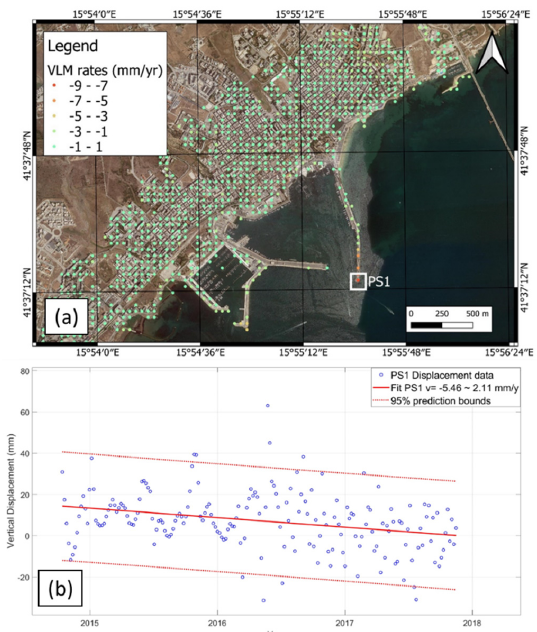
Figure 9. VLM rates inferred from the geodetic analysis (InSAR and GNSS data): ( a ) map of VLM rates in the Manfredonia municipality, computed on a regular grid of points, as explained in Section 3.2, with the greatest VLM at point PS1; ( b ) vertical displacement assessed through InSAR data for the dock, corresponding to point PS1.